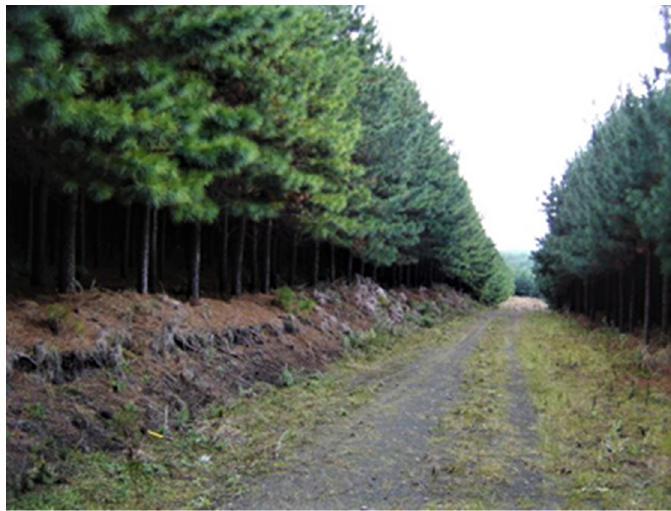
Figure 1. BattiStella loblolly pine at age 10 in the Rio Negrinho municipality of Santa Catarina, Brazil.